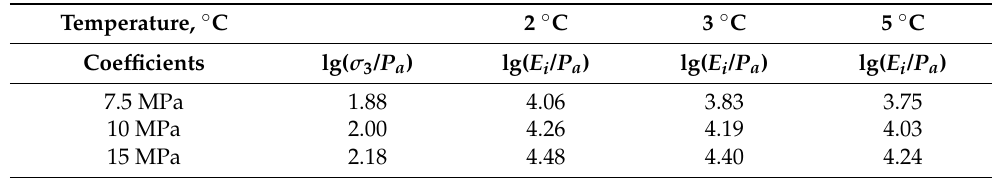
Table 3. Values of the coefficients of lg ( E i / P a ) and lg ( σ 3 / P a ) .